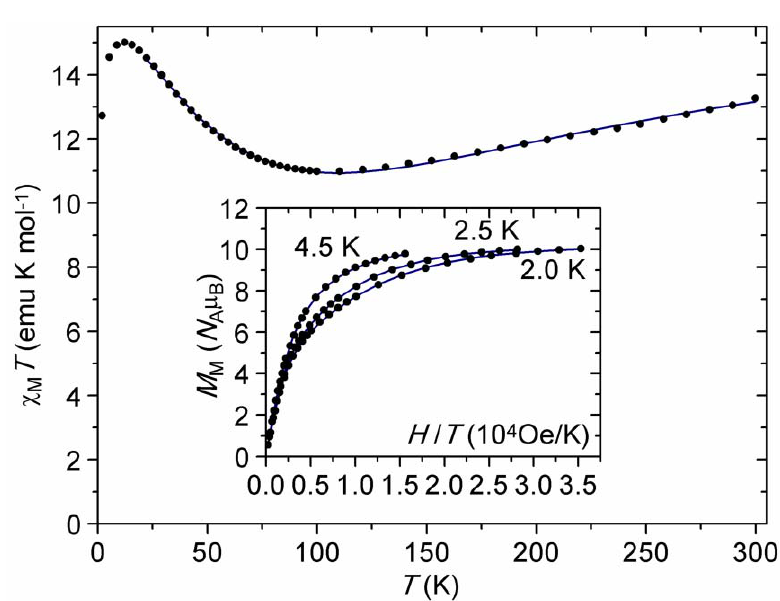
Figure 4. Temperature dependence of the molar magnetic susceptibility in low field, and molar magnetization isotherms at low temperature (inset) for 1 . Solid lines represent the best-fit curves. Table 1. Magnetic parameters for 1 , 2 ∙ Et 2 O, 3, and 12 .